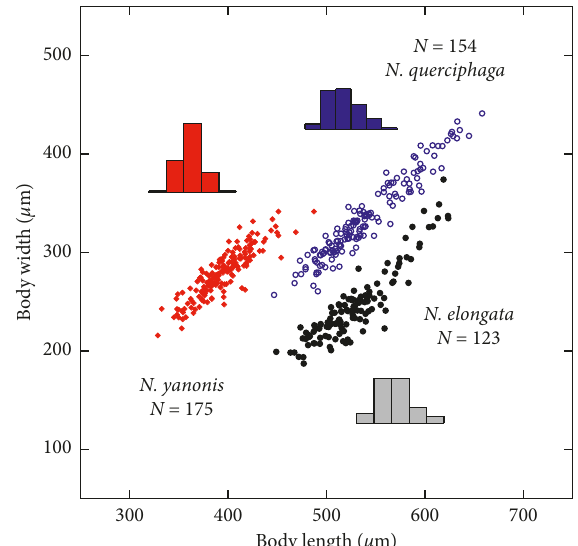
Figure 8: Scatter diagram of body length versus body width for apterous adults of Neothoracaphis yanonis (red squares), N. querciphaga (blue open circles), and N. elongata (black closed circles), each with a frequency distribution diagram of the body lengths (40 μ m for 1 unit of the